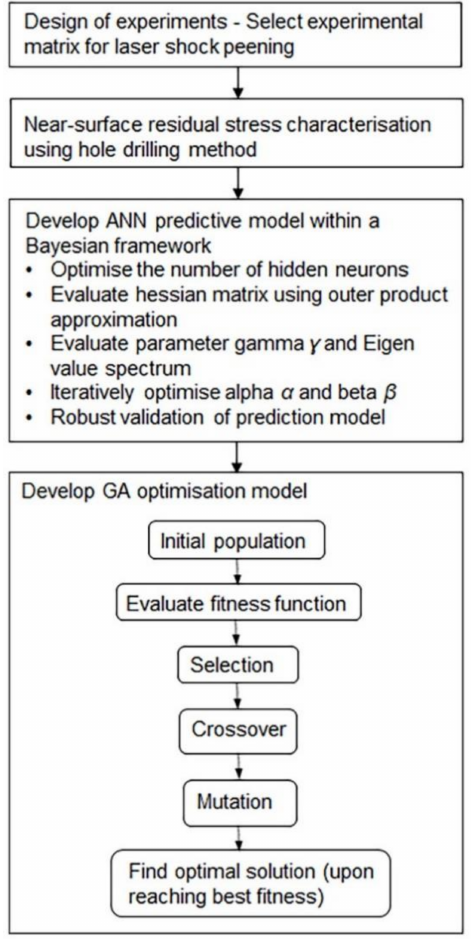
Figure 6. Flowchart of the ANN-genetic algorithm (GA) system. The ANN model is a forward prediction model used to determine the residual stress distribution based on the process parameters of the laser peening, and the GA model is a reverse optimisation model used to determine the optimum process parameters for the desired residual stress